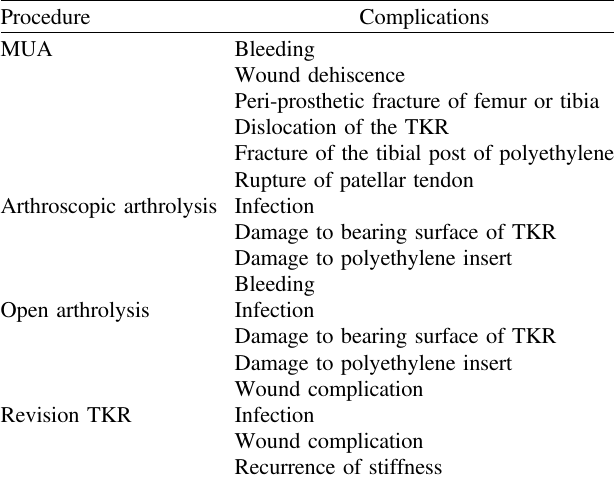
Table 2. Surgical options for stiffness and their possible complications.